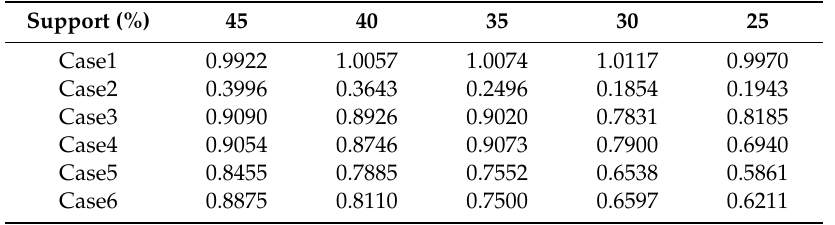
Figure 4. E ff ect of varying support from 25% to 45% on proportions of execution time in FDCNB- MINING and FLR-mining. Table 4. Proportions of execution time for FDCNB-MINING / FLR-mining while varying support from 25% to 45% and Case 1 to Case